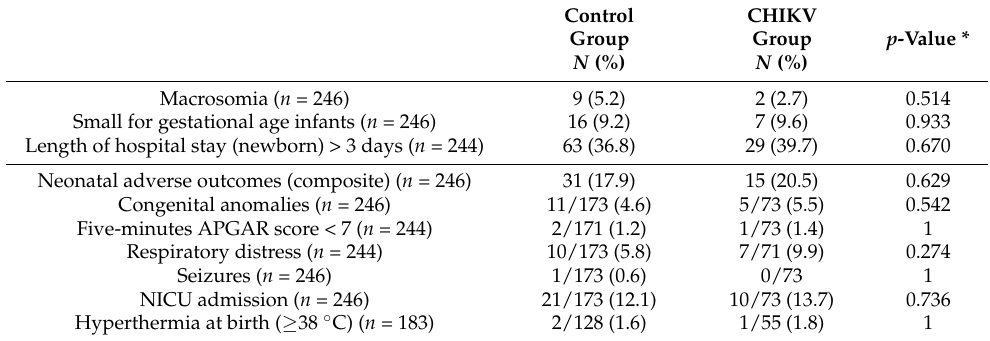
Table 4. Frequency and comparison of neonatal outcomes (pregCHIKV study 2022 N =